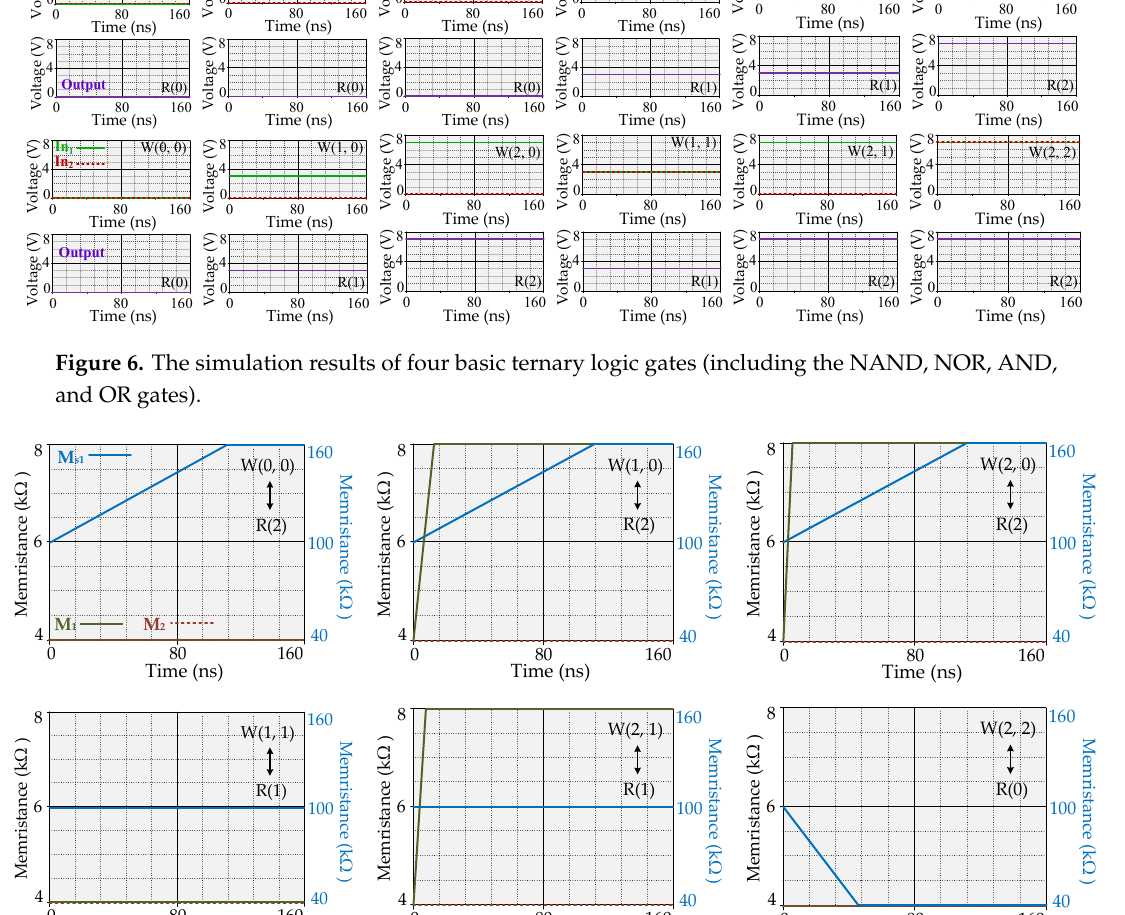
Figure 6. The simulation results of four basic ternary logic gates (including the NAND, NOR, AND, and OR gates).